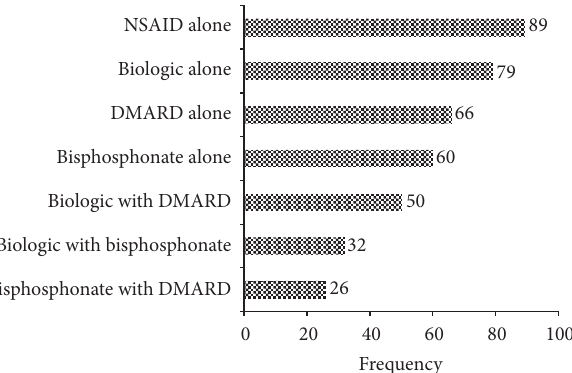
Figure 5: Preferred treatment choices for future comparative effectiveness trials in